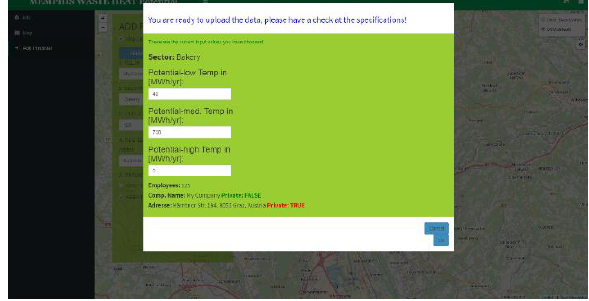
Figure 5. Waste Heat Explorer – User Interactions © AIT